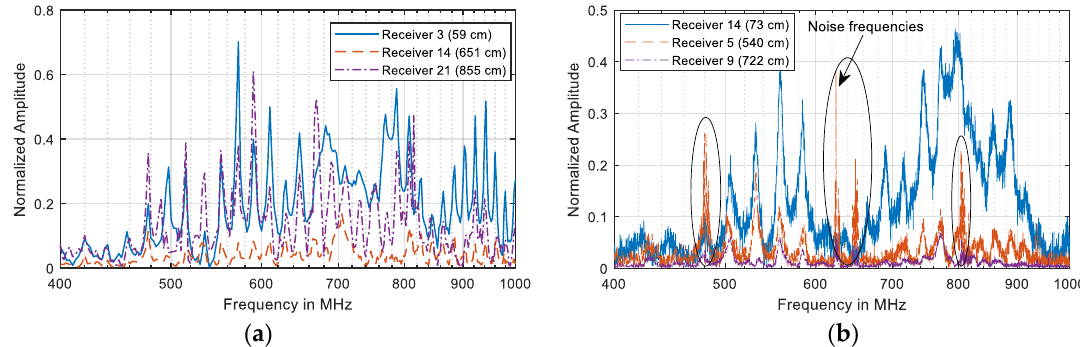
Figure 9. Comparison of the frequency spectra of signals received from receivers at varying LoS distances for ( a ) transformer A; ( b ) transformer B.